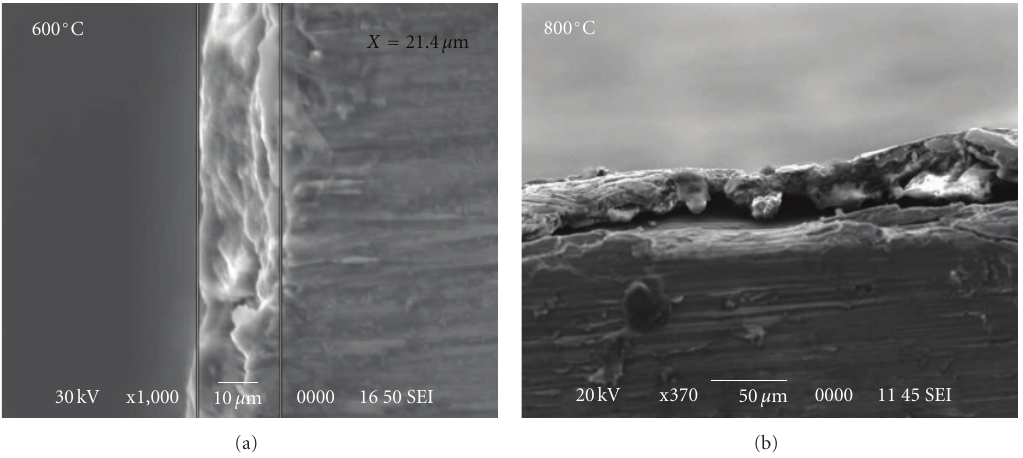
Figure 11: Cross-section microstructure of heat-treated HAe